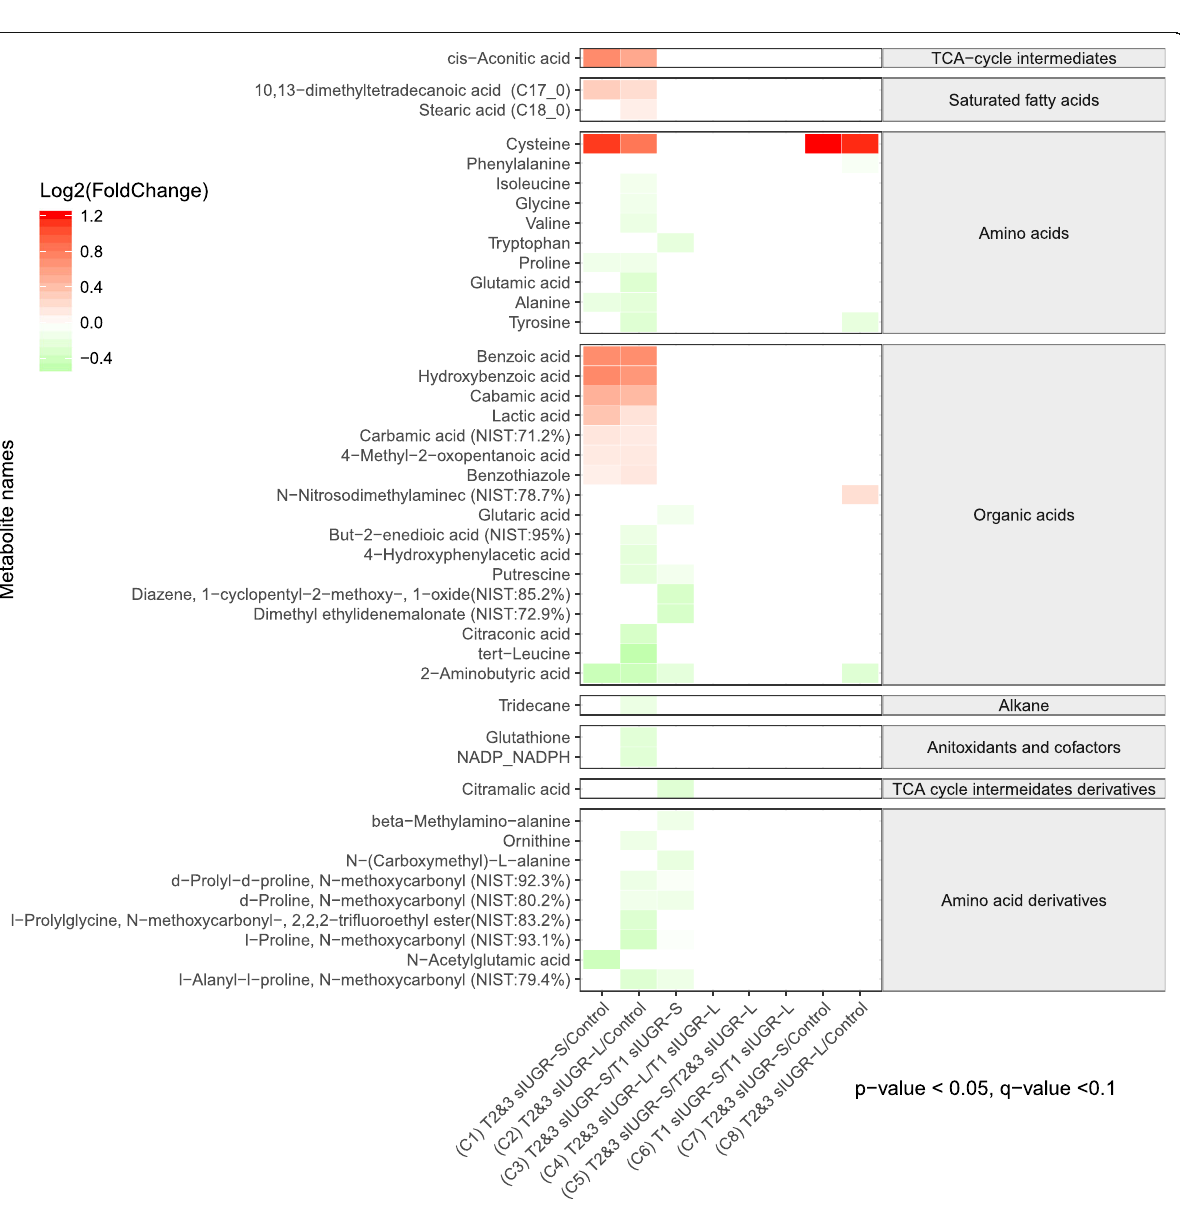
Fig. 5 The heatmap shows the differences in the hair metabolome and associated metabolic pathways between the eight comparisons of MCDA twins. The relative concentrations of hair metabolites are illustrated via a log 2 scale. Red color blocks represent higher metabolite levels in dividend groups than the divisor groups, whereas green color blocks represent lower metabolite levels in dividend groups than the divisor groups. Only the metabolites with a p -value less than 0.05 (Logistic regression adjusted for gestational age) and a q-value less than 0.01 (false discovery rate) are displayed. List of abbreviations; MCDA = Monochorionic diamniotic; sIUGR = Selective intrauterine growth restriction; T1 = Normal umbilical artery flow; T2&3 = Abnormal umbilical artery flow; L = Larger twin; S = Smaller